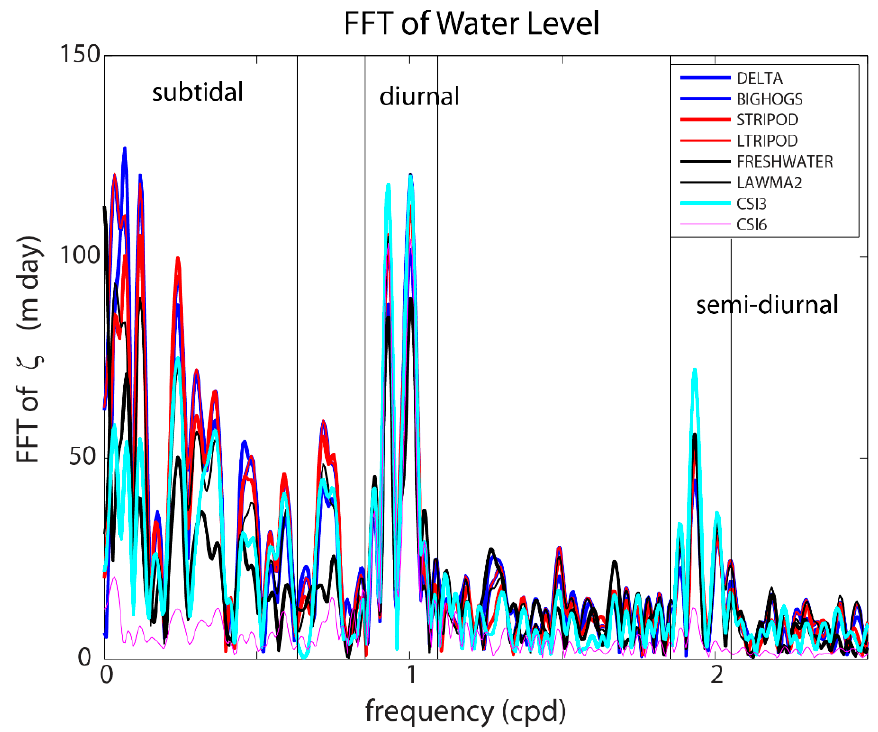
Figure 7. Amplitude spectra (0–2.5 CPD) of water levels at 13 stations.